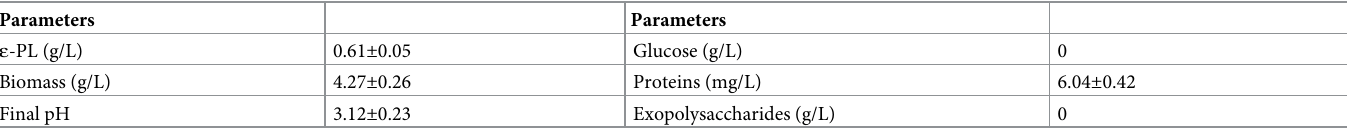
Table 1. Data on ε -PL fermentation in flasks by S . ahygroscopicus GIM8. Parameters